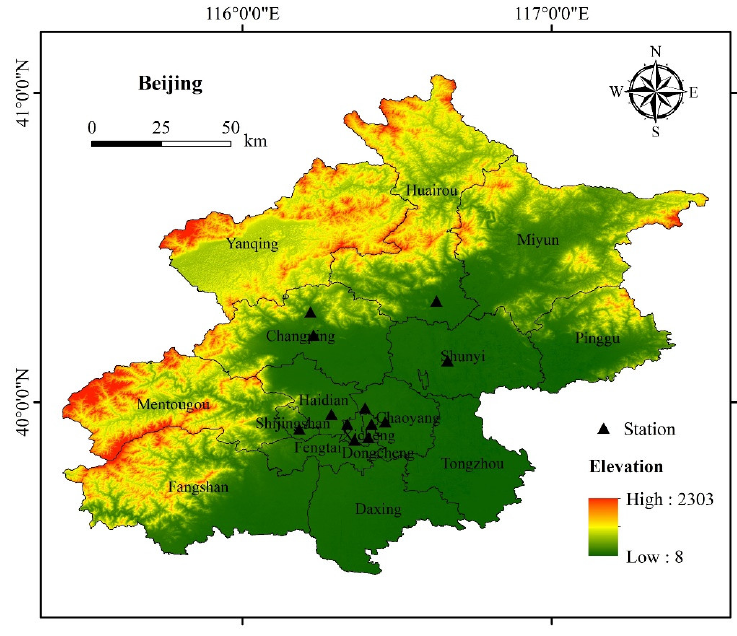
Figure 2. Distribution of PM 2.5 concentration monitoring stations.